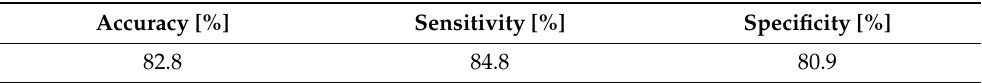
Table 11. Evaluation metric scores of the Binary Logistic Regression Model expressed in percentage